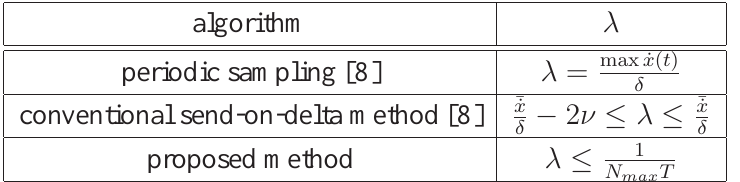
Table 1 . Mean rate of messages comparison for 3 different algorithms